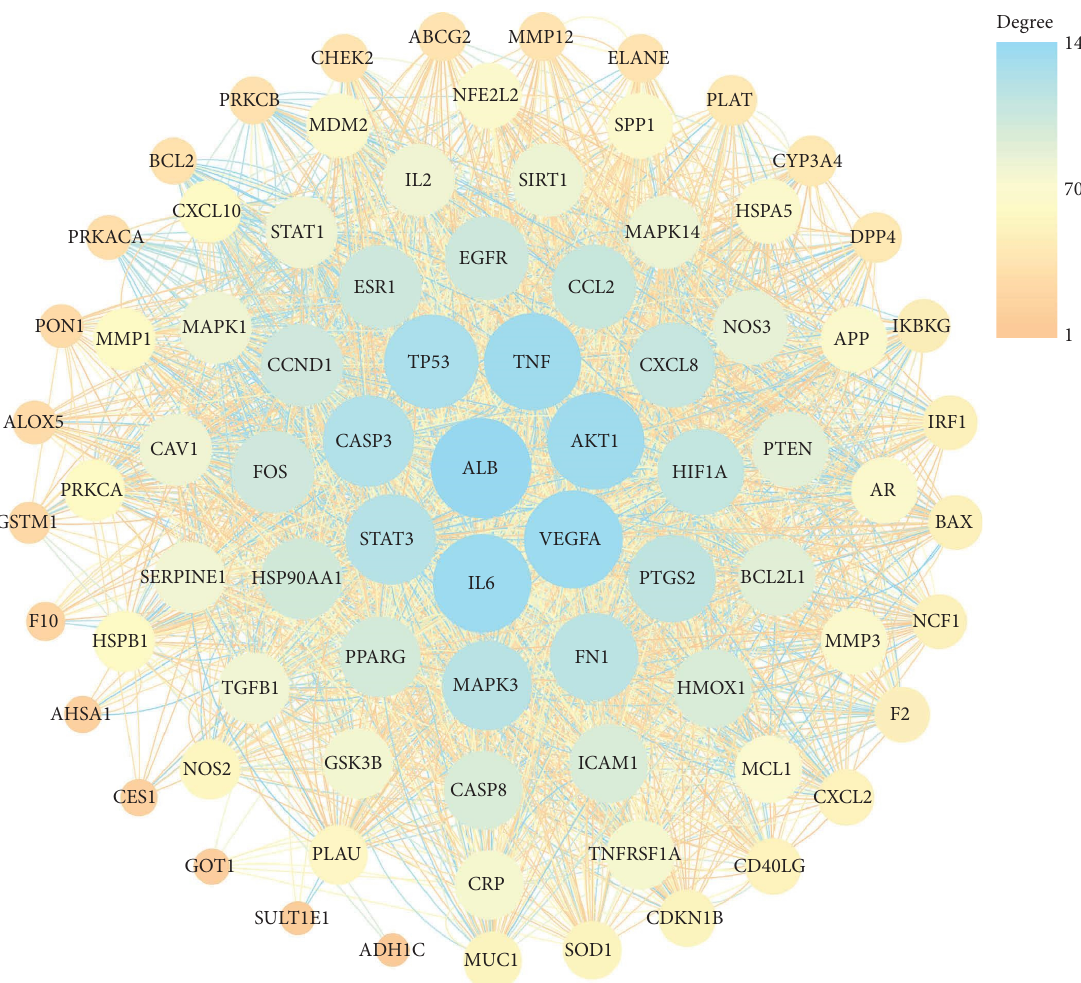
Figure 3: PPI network of intersection targets. Te area of the node in Figure 3 is proportional to the degree